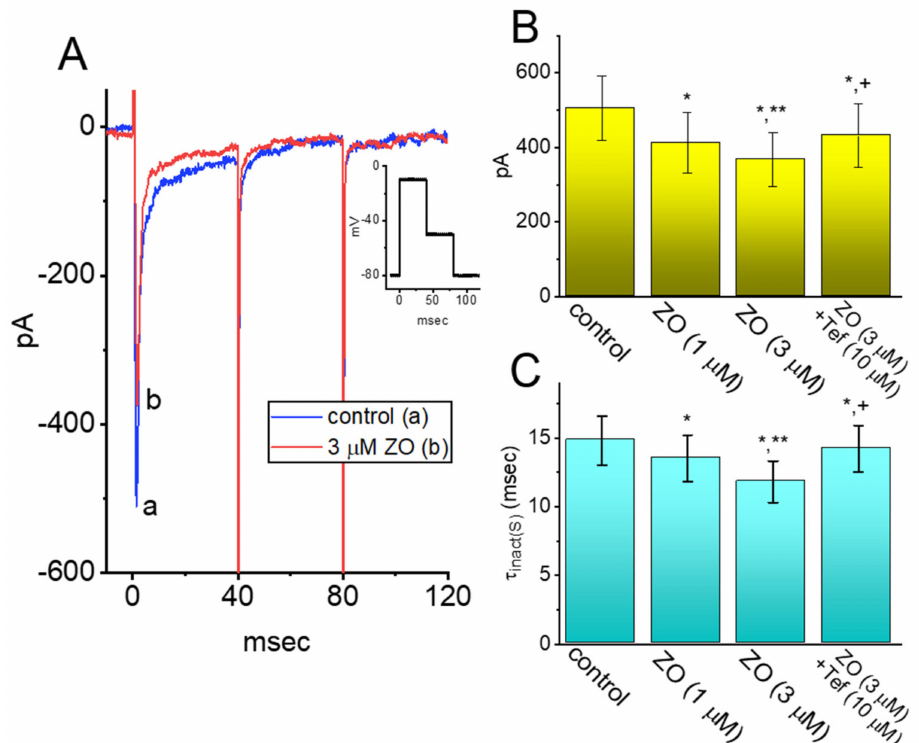
Figure 8. Inhibitory effect of ZO on I Na on mHippoE-14 hippocampal neurons. ( A ) Representative current traces obtained in the absence (a) or presence of 1 µ M ZO (b). The inset shows the pulse protocol used in this study. Panel ( B , C ) are summary bar graphs demonstrating the effects of ZO and ZO plus Tef on the peak amplitude or τ inact(S) of depolarization-activated I Na , respectively (mean ± SEM; n = 7 for each bar). * Significantly different from the control ( p < 0.05), ** significantly different from the 1 µ M ZO-alone group ( p < 0.05), and + significantly different from the 3 µ M ZO-alone group ( p < 0.05). Panel ( A ): (One-way ANOVA, F(3,24) = 3.351, p = 0.03) and panel ( B ): (One-way ANOVA, F(3,24) = 4.012, p =